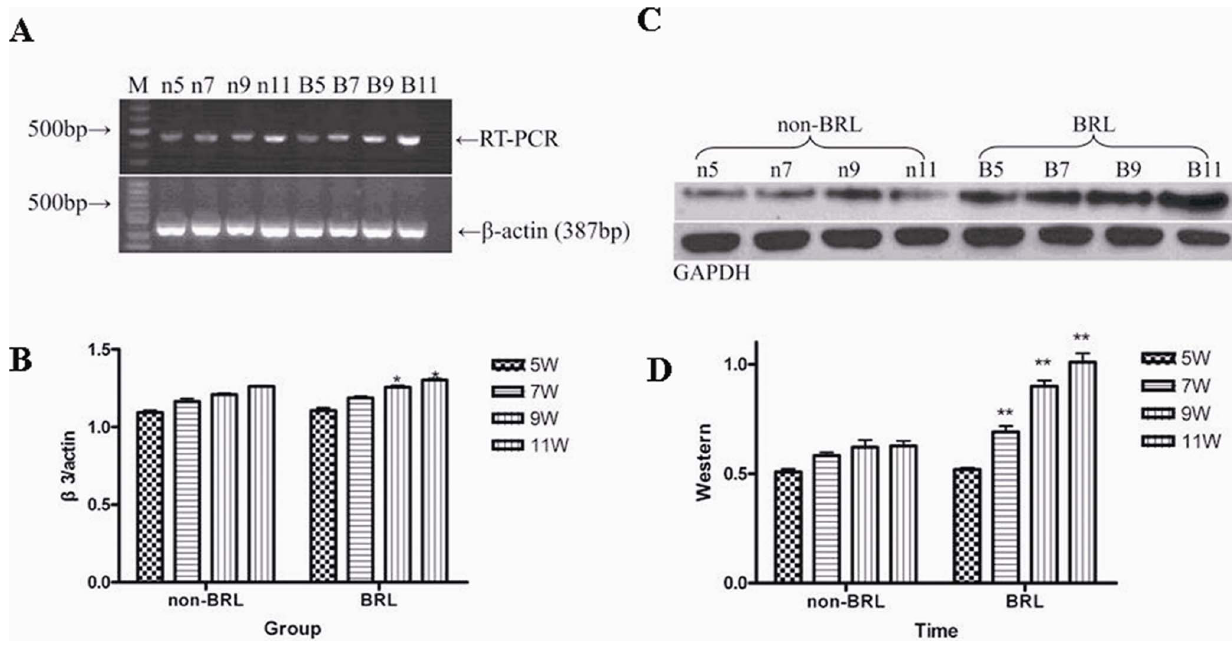
Figure 5. Myocardiac b 3-AR mRNA by RT-PCR and b 3-AR Protein by Western blot. (A) Representative analysis of myocardiac b 3-AR mRNA level by RT-PCR. Lane M: marker; bp: base pair; lane n5: the 5 th week, non-BRL group; lane n7: the 7 th week, non-BRL group; lane n9: the 9 th week, non-BRL group; lane n11: the 11 th week, non-BRL group; lane B5: the 5 th week, BRL group; lane B7: the 7 th week, BRL group; lane B9: the 9 th week, BRL group; lane B11: the 11 th week, BRL group. (B) Bar plot showed the data from myocardial tissues of all animals in each group. Data were analyzed by ANOVA. The expression of b 3-AR was significantly higher at the 9 th and 11 th week in the BRL group than that in the Banded group (* p , 0.05, BRL group vs. Banded group). The b 3-AR revealed a time-dependent increase in each group ( p , 0.01). (C) Immunoblot of myocardiac b 3-AR protein in representative animals. Lane n5: the 5 th week, non-BRL group; lane n7: the 7 th week, non-BRL group; lane n9: the 9 th week, non-BRL group; lane n11: the 11 th week, non-BRL group; lane B5: the 5 th week, BRL group; lane B7: the 7 th week, BRL group; lane B9: the 9 th week, BRL group; lane B11: the 11 th week, BRL group. GAPDH: glyceraldehyde phosphate dehydrogenase. (D) Bar plot showed the data from myocardiac tissues of all animals in each group. The data were analyzed by ANOVA. At each time point (except 5 wk), the expression of b 3-AR protein was significantly higher in the BRL group than that in the Banded group. The expression of b 3-AR protein revealed a time-dependent increase, and its expression at the 11 th week was significantly higher than that at the 5 th week ( p , 0.01, Banded group: 0.62 6 0.08 vs. 0.51 6 0.03; BRL group: 1.01 6 0.10 vs. 0.52 6 0.02). (** p , 0.01, BRL group vs. Banded group). BRL group: HF group with b 3 -AR agonist BRL37344 injection; non-BRL: HF group without BRL37344 injection.